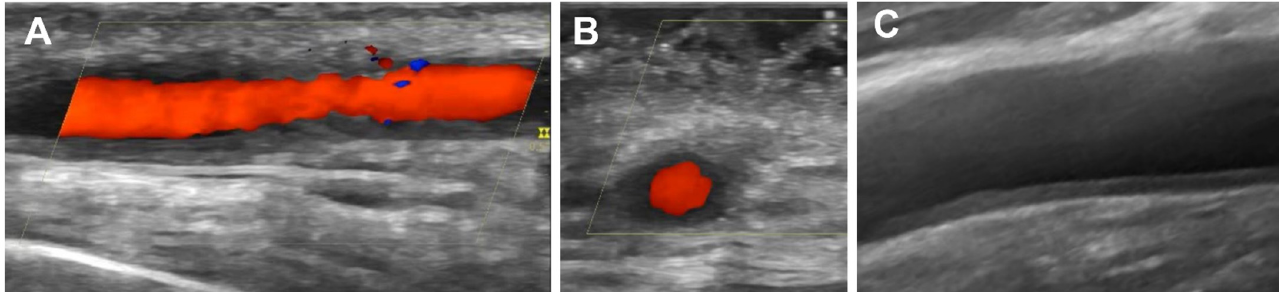
Figure 1. “Halo sign” on temporal and axillary arteries: ( A ) longitudinal view of the temporal parietal artery branch; ( B ) transverse view of the temporal parietal artery branch; ( C ) longitudinal view of the axillary artery.